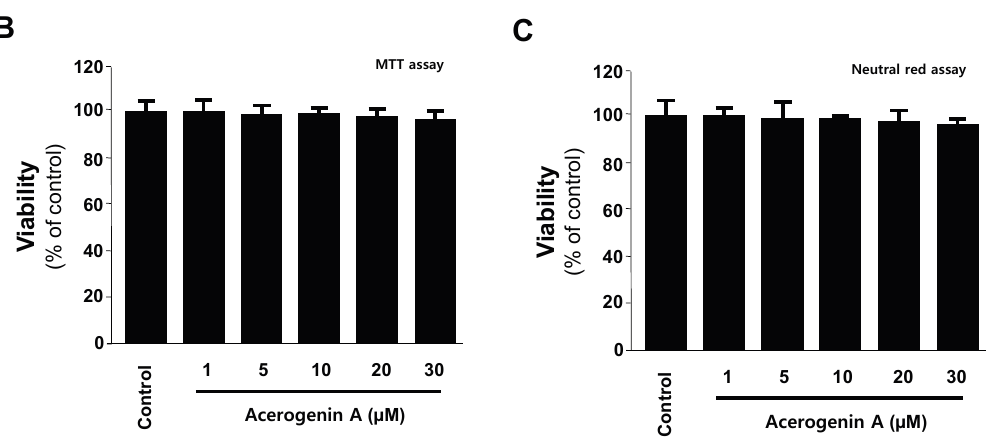
Figure 1. The structure of acerogenin A ( A ) and the effects of acerogenin A on cell viability by MTT assay ( B ) and neutral red assay ( C ). HT22 cells were incubated for 48 h with various concentrations of acerogenin A (1–30 μ M) ( B , C ). Data are presented as mean ± SD values of three independent experiments.